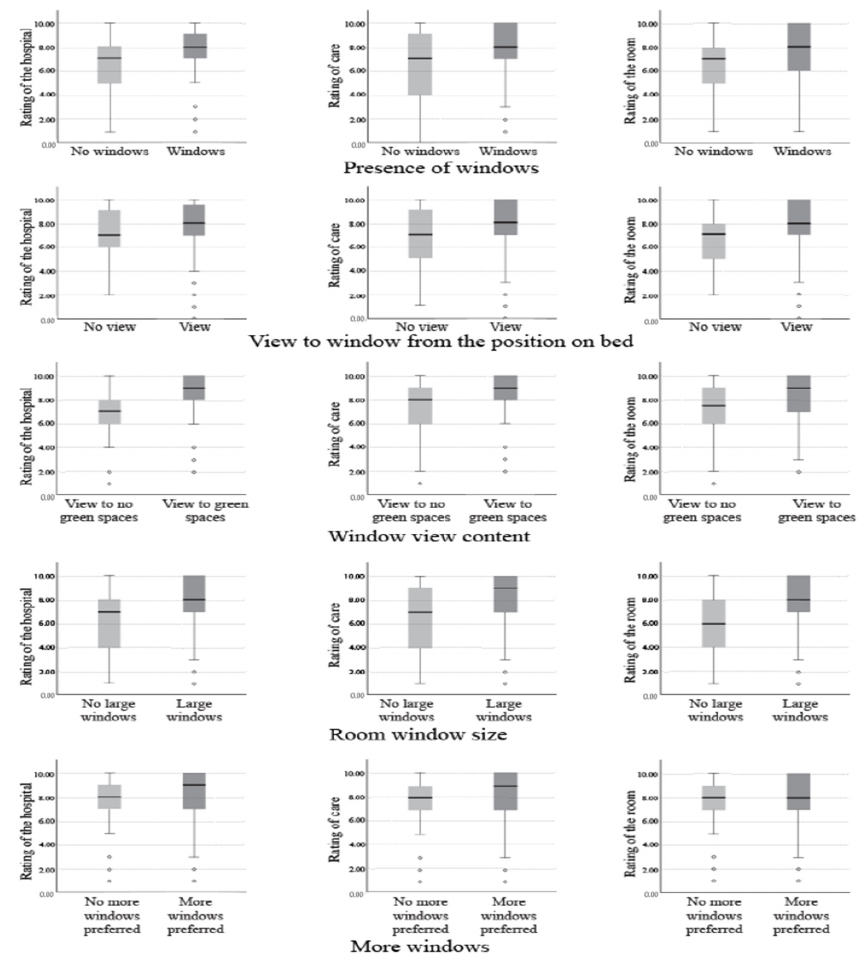
Figure 1. The distribution of scores for windows, views, window view content, window size, and